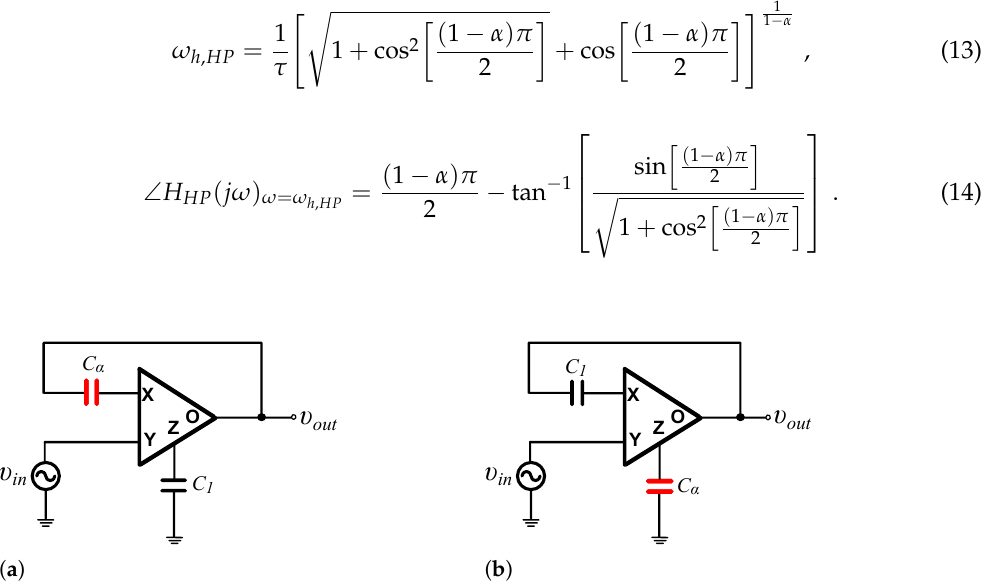
Figure 3. Implementations of fractional-order ( a ) low pass and ( b ) high pass filters using the structures in Figure